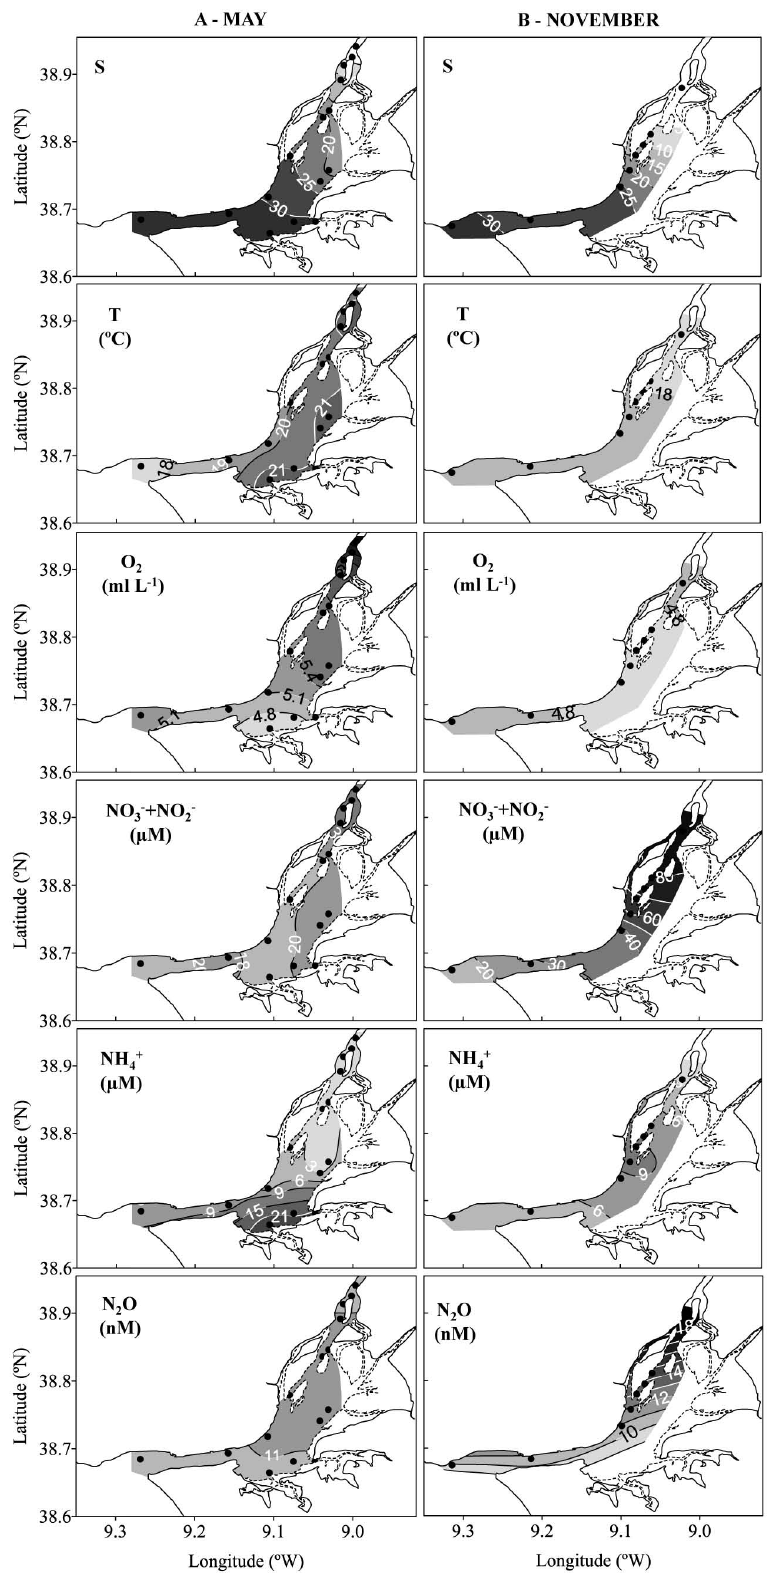
Fig . 2. – Spatial distribution of physical (Salinity (S) and Temperature (T)) and chemical parameters (dissolved oxygen (O + NO 2– , NH 4+ ) and nitrous oxide (N O) in (A) May and (B) November 2